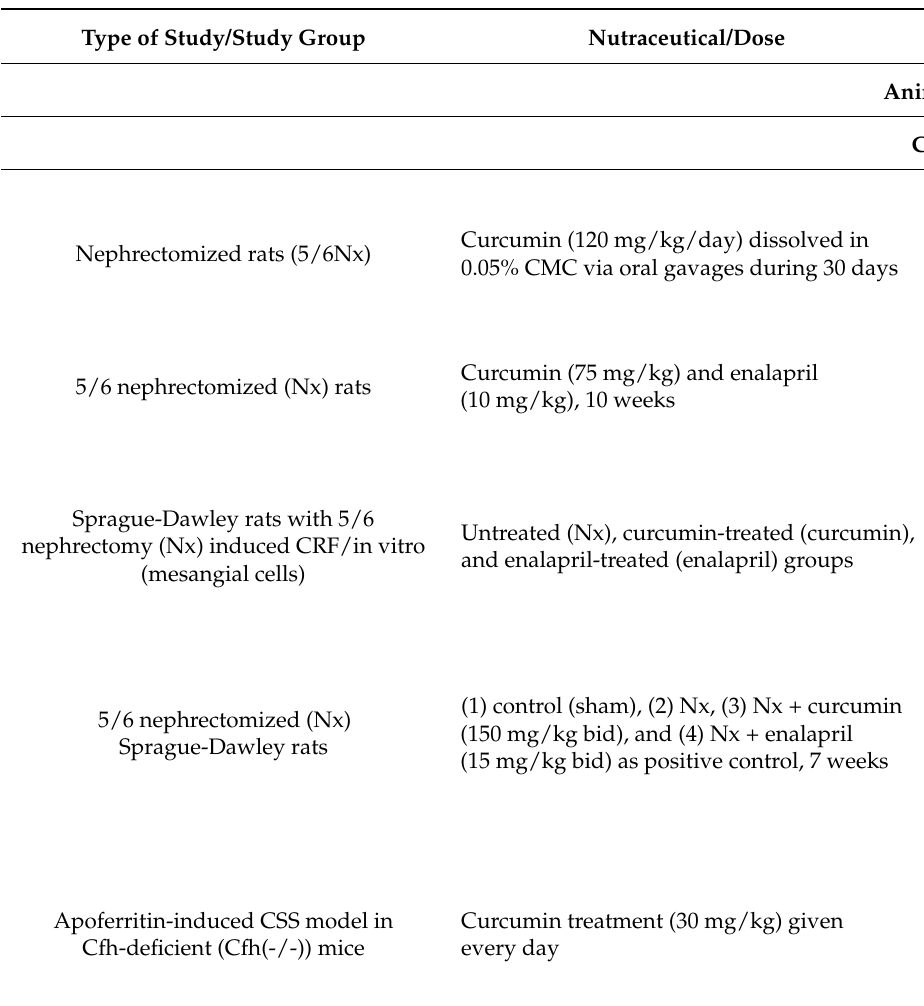
Table 1. The summary of the effect of nutraceuticals use in CKD—the results of animal and human